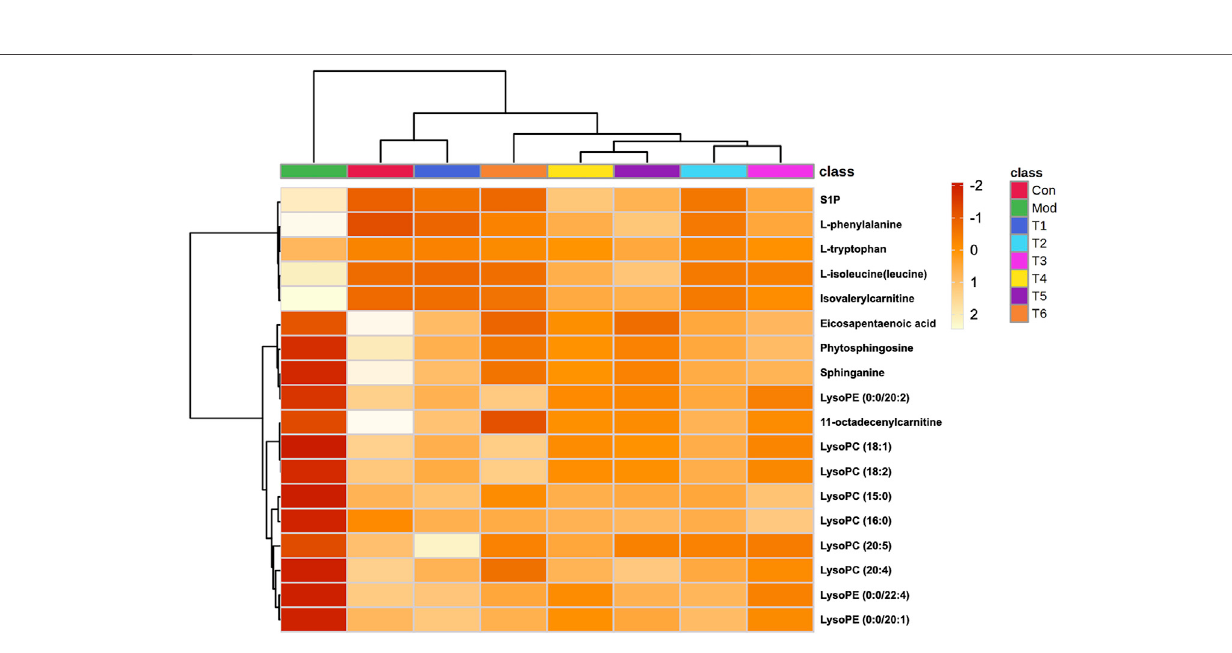
Frontiers in Pharmacology |